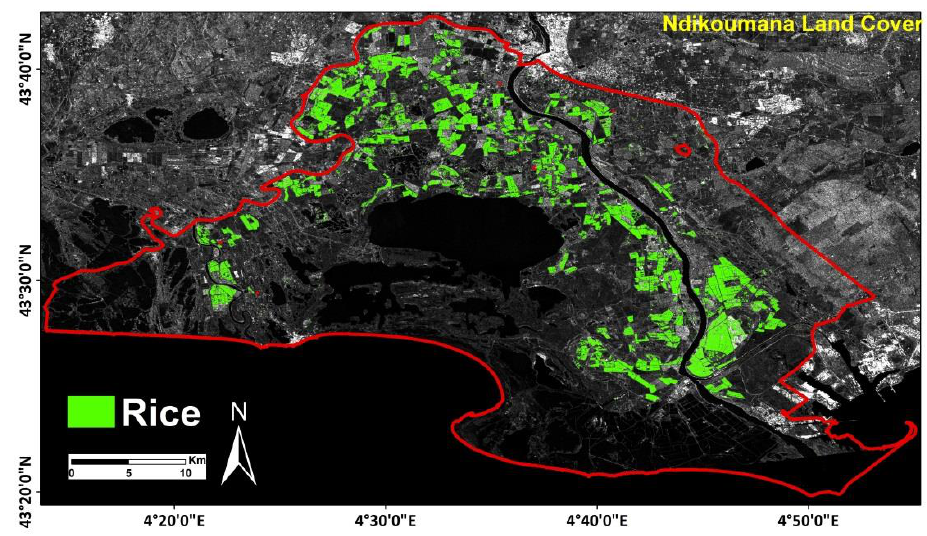
Figure 10: Rice areas in Camargue in 2017 extracted from Ndikumana et al. [25] land cover map. The The background is a SAR image in VV background is a SAR image in VV polarization.